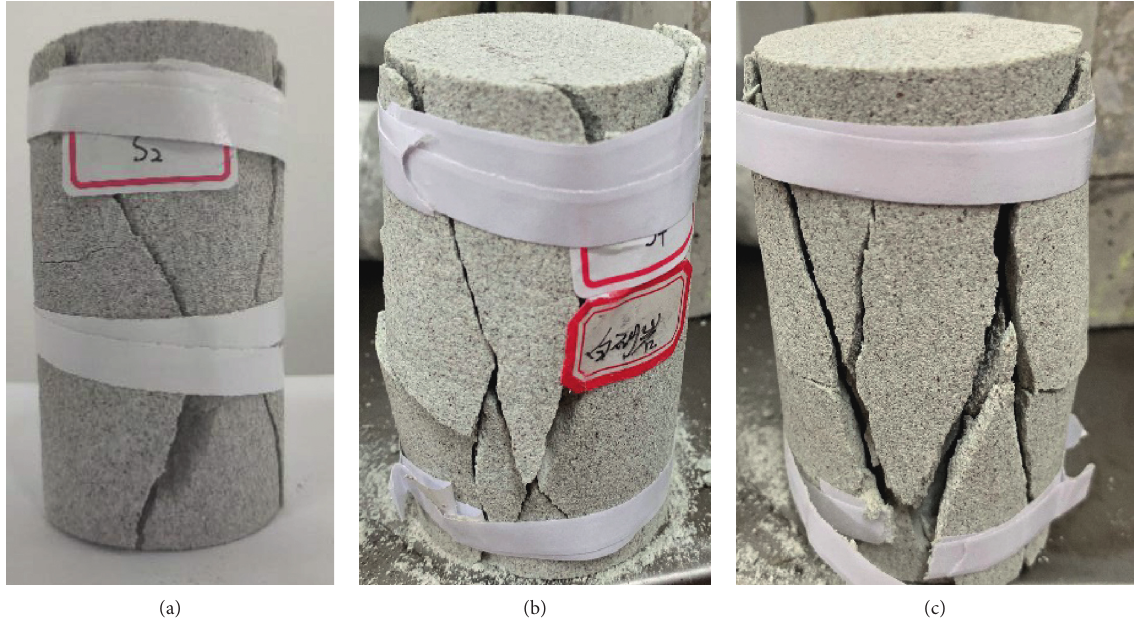
Figure 6: Macroscopic failure modes of rock samples on different moisture conditions during the uniaxial compression test. (a) Dry state. (b) Natural state. (c) Water-saturated